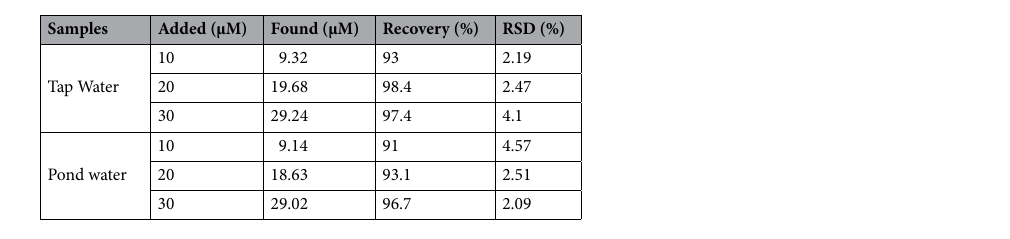
Table 1. Different real water samples analysis using Cu/Ni/TiO 2 /MWCNTs nanocomposites.